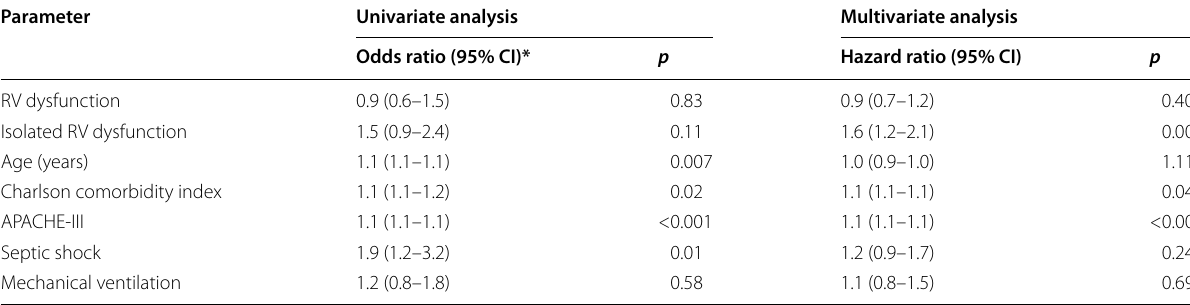
Represented as : odds ratio (95% confidence interval) or hazard ratio (95% confidence interval) APACHE-III Acute Physiology and Chronic Health Evaluation III, CI confidence interval *Unit OR are presented for continuous